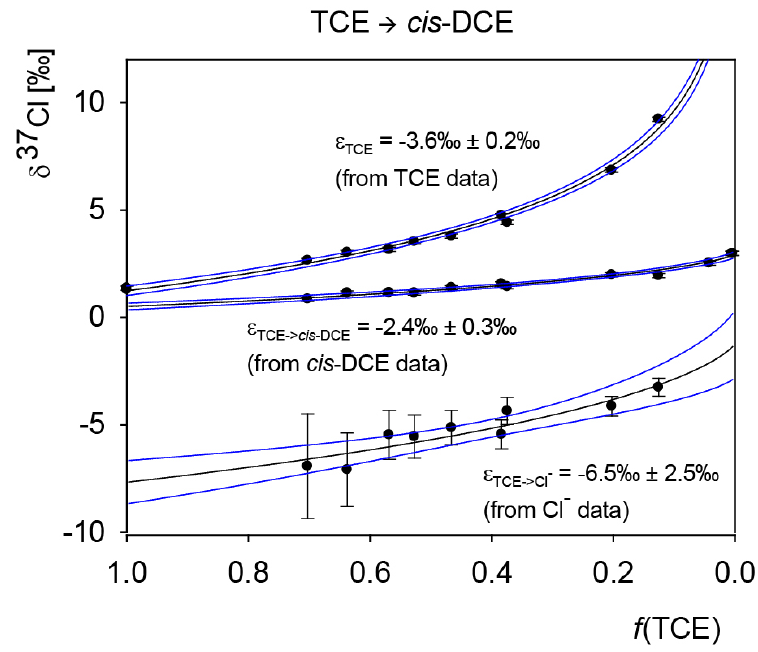
Figure 6. Chlorine isotope data of TCE degradation to cis -DCE and chloride by Geobacter lovleyi strain SZ including mathematical fits in Sigma Plot according to the presented mathematical approach. Error bars of individual data points indicate standard deviations; uncertainties of the regressions are 95% confidence